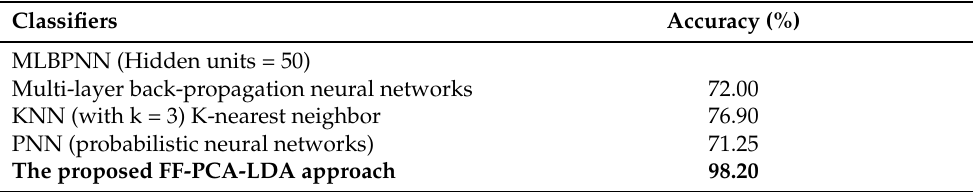
Figure 7. Class-wise ROC curves of the proposed FF-PCA-LDA approach. Table 3. Performance comparison of the proposed approach with other